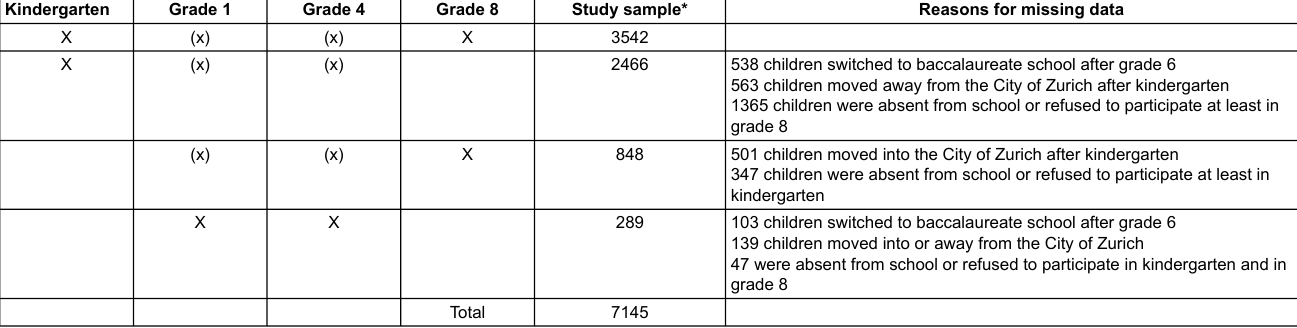
Table 1: Study sample: participation of the children in the various examinations and reasons for missing data.